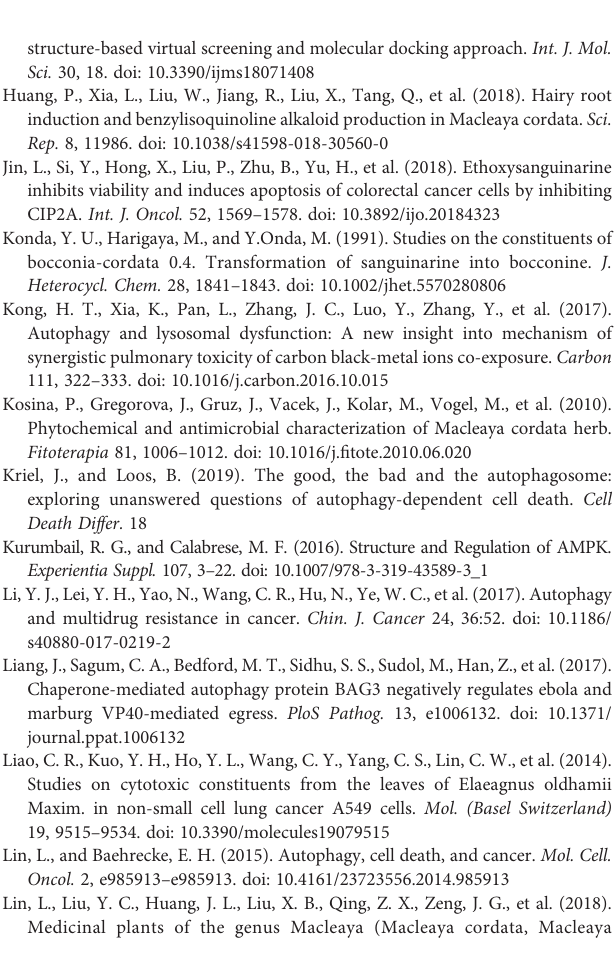
FIGURE S1 | Nuclear magnetic resonance analysis of Bio-Eth. FIGURE S2 | Eth impairs glucose metabolism in BC cells MCF-7 or MDA-MB- 231cells were treated with increasing concentrations of Eth for 24 h. Western blot wasperformed using antibodies indicated. FIGURE S3 | Uncropped immunoblot for some